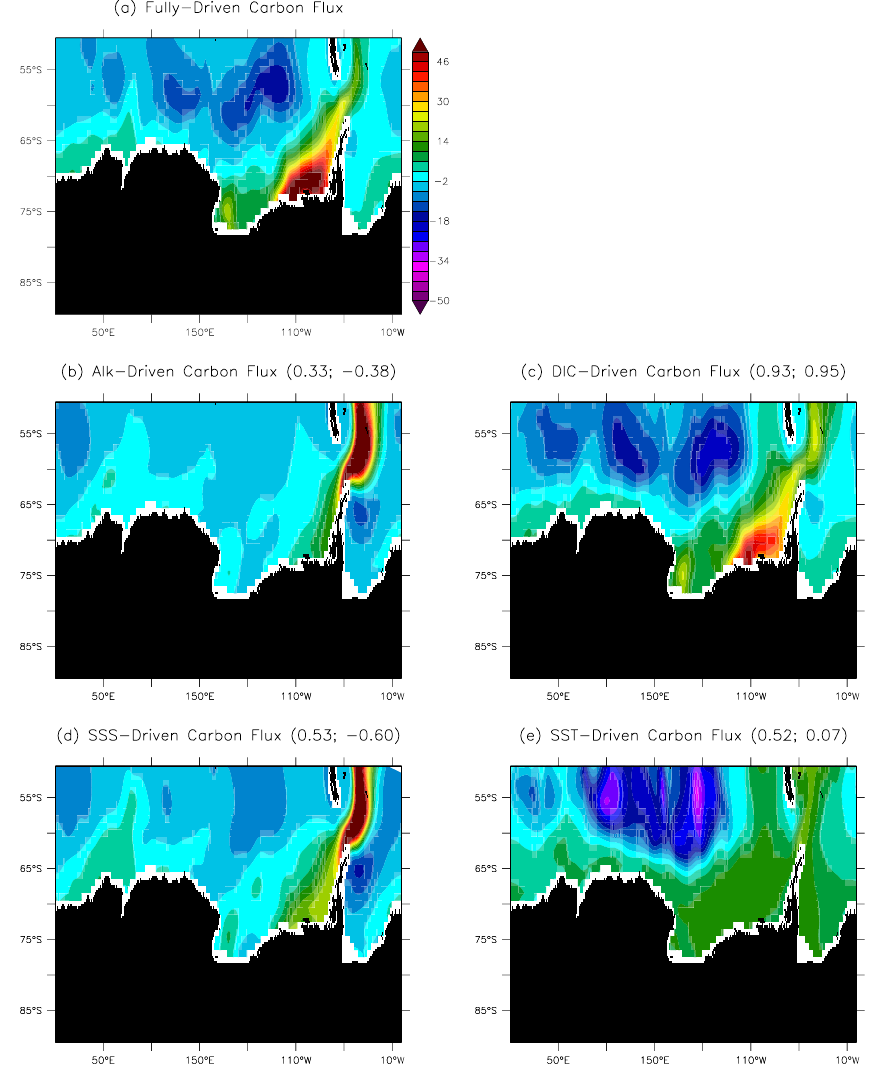
Fig. 7. Spatial pattern of the leading empirical orthogonal function (EOF, in normalised unit) of (a) the fully-driven carbon fluxes, and that of the Alk-driven (b) , DIC-driven (c) , SSS-driven (d) and SST-driven (e) ocean carbon fluxes in the Southern ocean. Spatial correlations (based on EOFs) and temporal correlations (based on CPs) between the fully-driven ocean carbon fluxes and each driver-related carbon fluxes are mentioned in